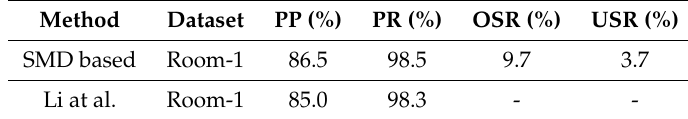
Table 5. Comparison of the proposed method (SMD) vs. Li et al.